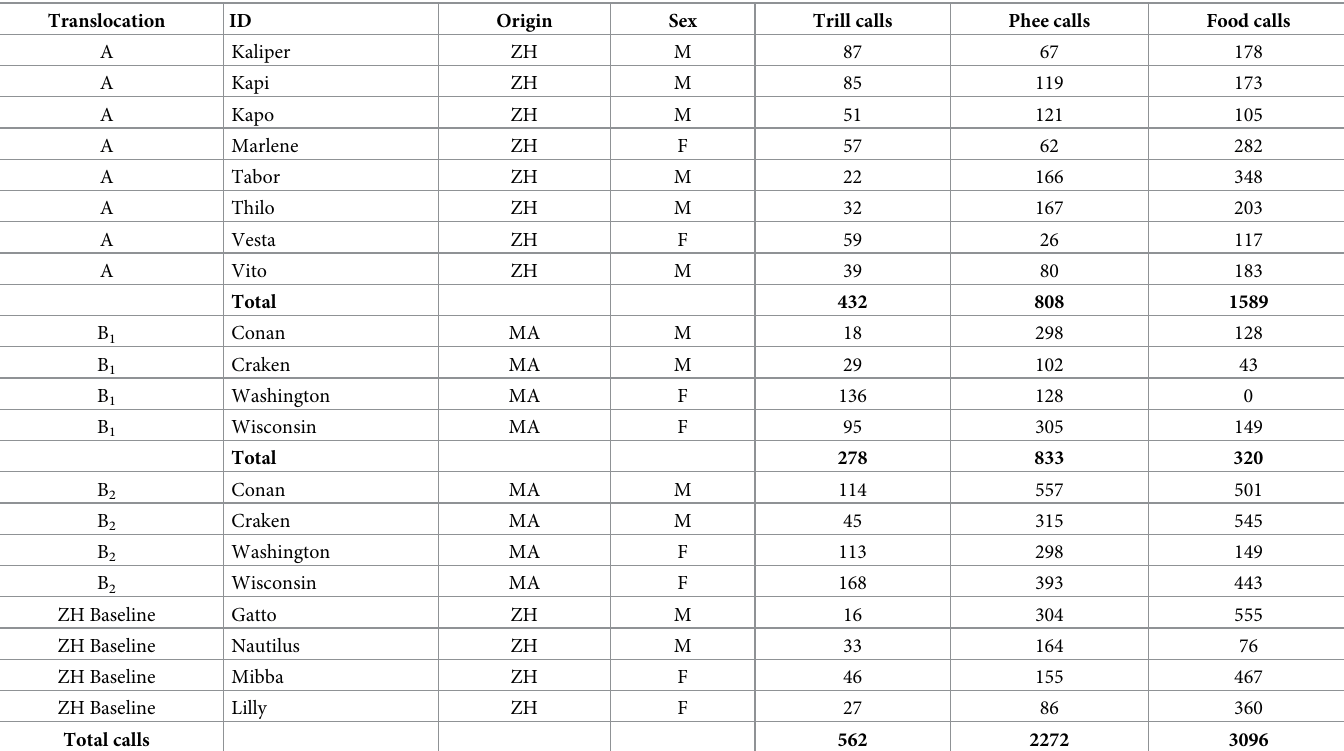
Table 4. Overview of the number of calls used in the different analyses and of the individual contribution to the